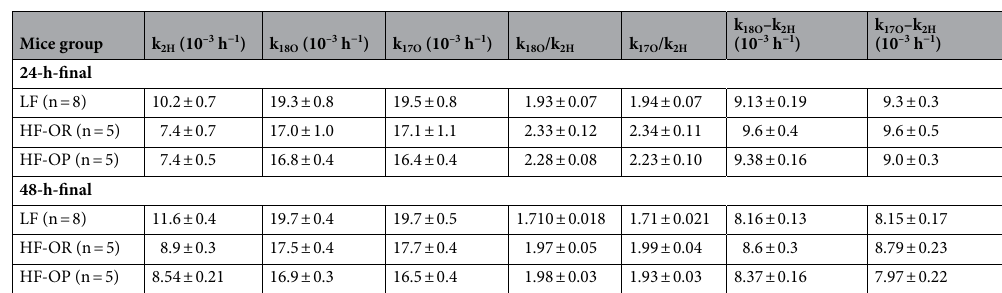
Table 5. The turnover rates (10 −3 h −1 ) for 2 H (k 2H ), 18 O (k 18O ) 17 O (k 17O ); turnover rates ratio: k 18O /k 2H and k 17O /k 2H ; turnover rates differences (10 −3 h −1 ): k 18O –k 2H and k 17O –k 2H . The ratios and differences are calculated from the individual initial isotope abundances (2-h after injection) and two finals (24 h and 48 h after the initial sample taken), and are expressed as mean ±